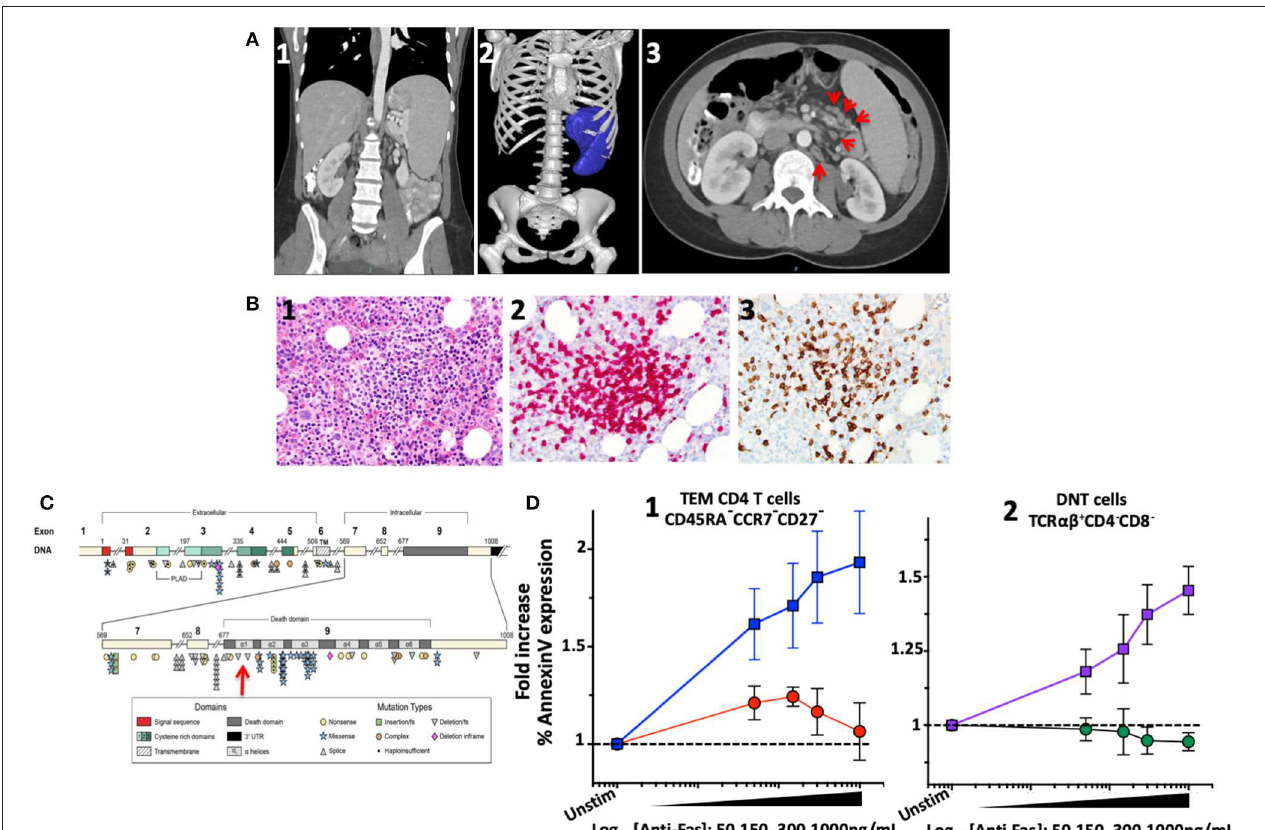
FIGURE 1 | Imaging, bone marrow biopsy findings and characterization and location of the novel FAS heterozygous variant in a patient with CD4 lymphopenia and ALPS. (A) Computed tomography of abdomen and pelvis. (1) Coronal section: Splenomegaly. (2) Splenic volume estimation by 3D reconstruction: 1,034 milliliter (mL) (normal 200 ± 50mL). (3) Axial section: Paraortic and mesenteric lymphadenopathy. (B) Bone marrow biopsy showing scattered lymphocytic aggregates with prevalence of CD8 + cells. (1) Lymphocytic aggregate in hematoxylin and eosin staining at 200x magnification. (2) CD3 Immunohistochemistry (IHC) staining. (3) CD8 IHC staining. (C) Diagram of the FAS gene identifying intron/exon structure and protein domains. Mutations are indicated at their approximate location and identified by symbols corresponding to mutation type. The new mutation identified in the index patient indicated by the red arrow. Figure adapted by Hsu et al. (3). (D) FAS-induced apoptosis was evaluated in terminal effector memory cells (TEM) and TCR αβ + DN T cells of index patient and healthy subjects using an ex vivo flow cytometric assay based on FAS crosslinking. (1) Average fold increase ± standard error of mean (SEM) of Annexin-V expression in TEM (CD45RA − CCR7 − CD27 − ) from 4 independent experiments with index patient (red) and 8 different healthy controls (blue) with different concentrations of anti-FAS crosslinking antibody. (2) Average fold increase ± SEM of Annexin-V expression in DNT cells (TCR αβ + CD4 − CD8 − ) from 4 independent experiments with index patient (green) and 8 different healthy controls (purple) with different concentrations of anti-FAS crosslinking